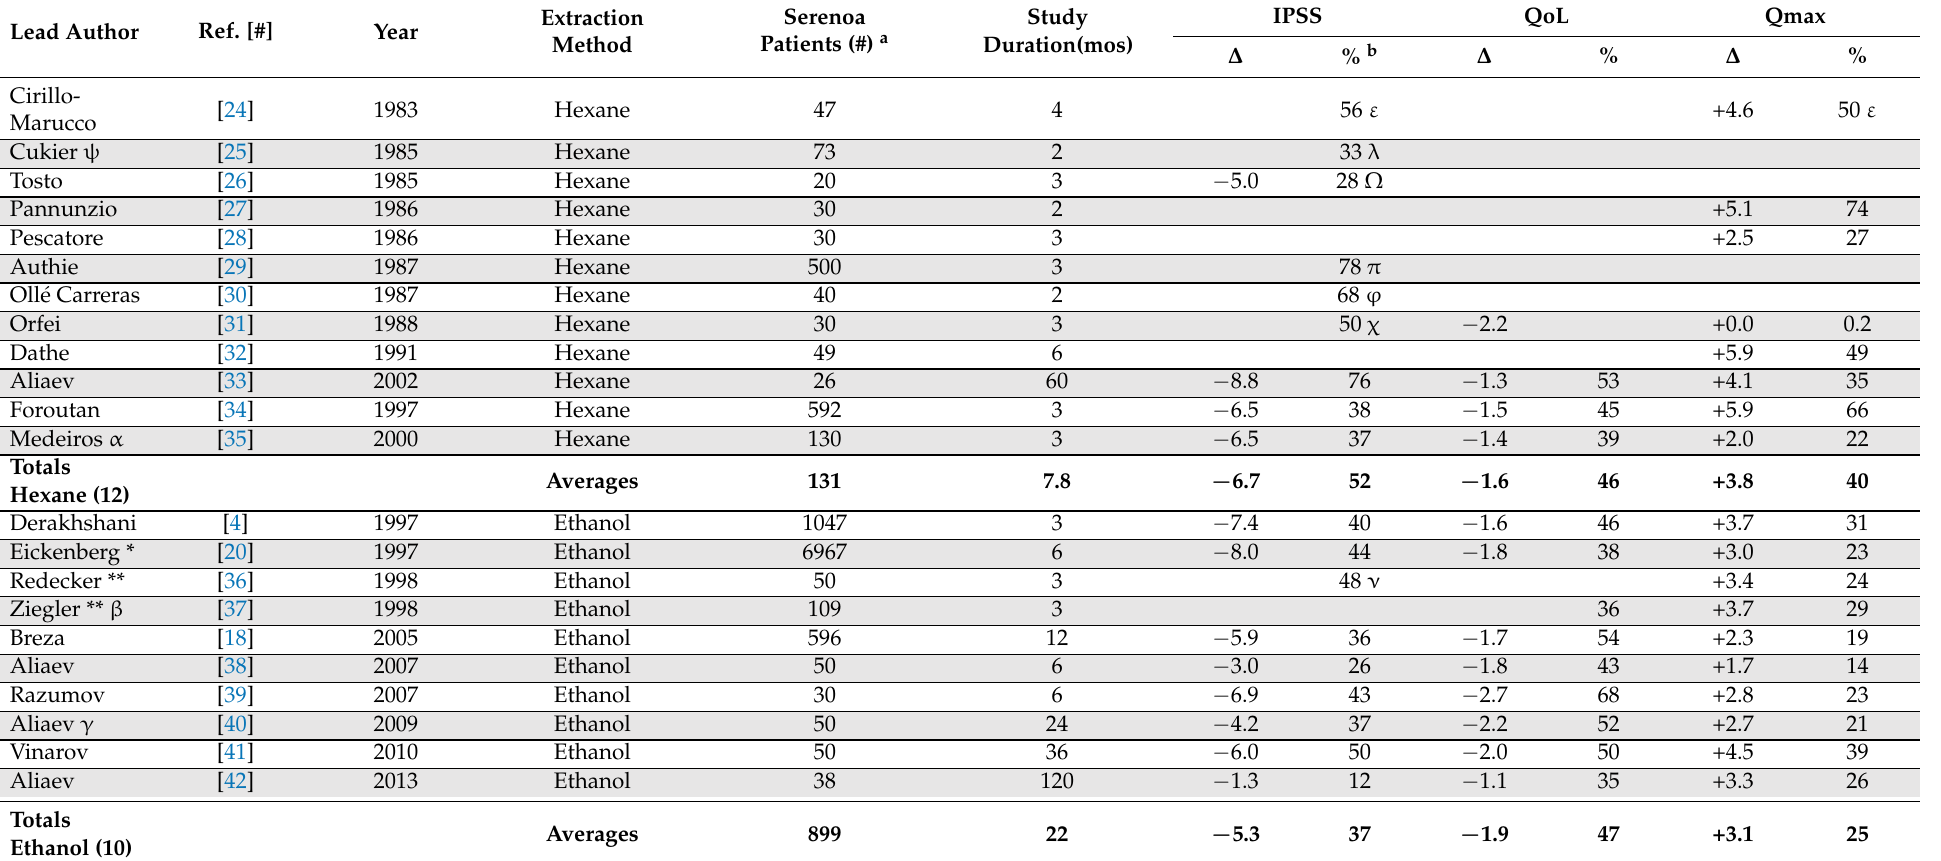
Table 6. Evaluable non-English-language papers (27 studies) categorized by extraction method. The mean number of patients, duration of the study, and the key clinical outcome assessments are detailed. The extensive footnotes report key findings of individual